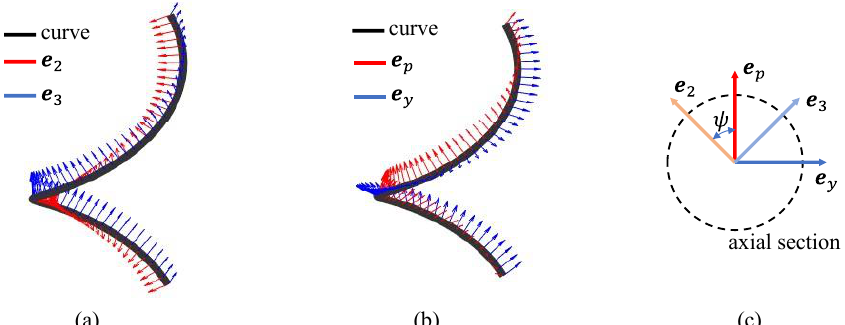
Figure 2. Difference between the Frenet–Serret frame and backbone curve reference set. ( a ) Direction diagram of curvature and deflection on the Frenet-Serret frame. ( b ) The component of curvature on the backbone curve reference set after the torsion direction. ( c ) The relationship between the Frenet-Serret frame and backbone curve reference set at axial section.